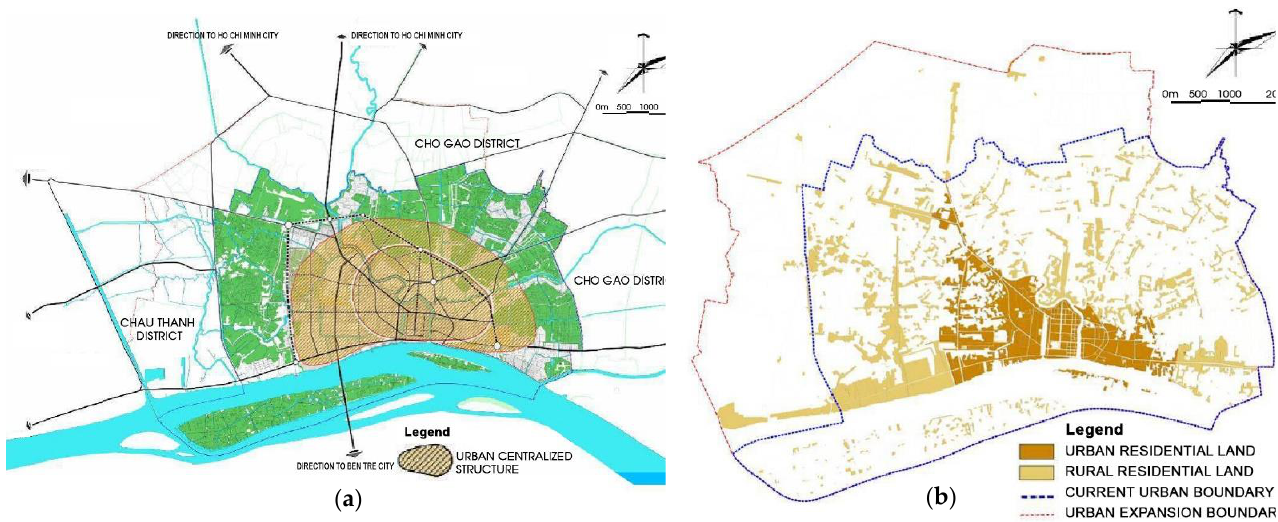
Figure 8. My Tho City today is a densely concentrated urban strip on the Mekong (Tien) River ( a ); the areas that are planned or under construction are eroding the identity of a water city ( b ). Source: Adapted from SISP.